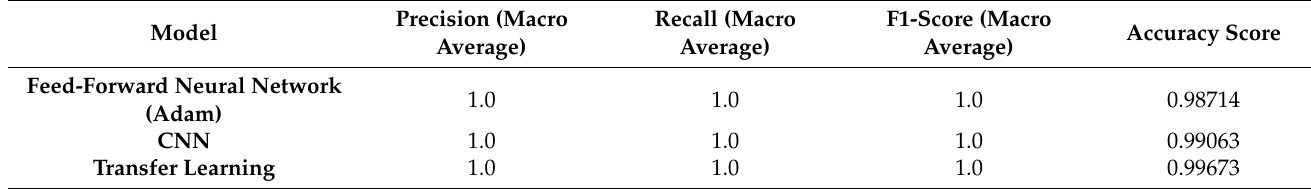
Table 7. Standalone deep-learning models trained on the Arabic MNIST digit